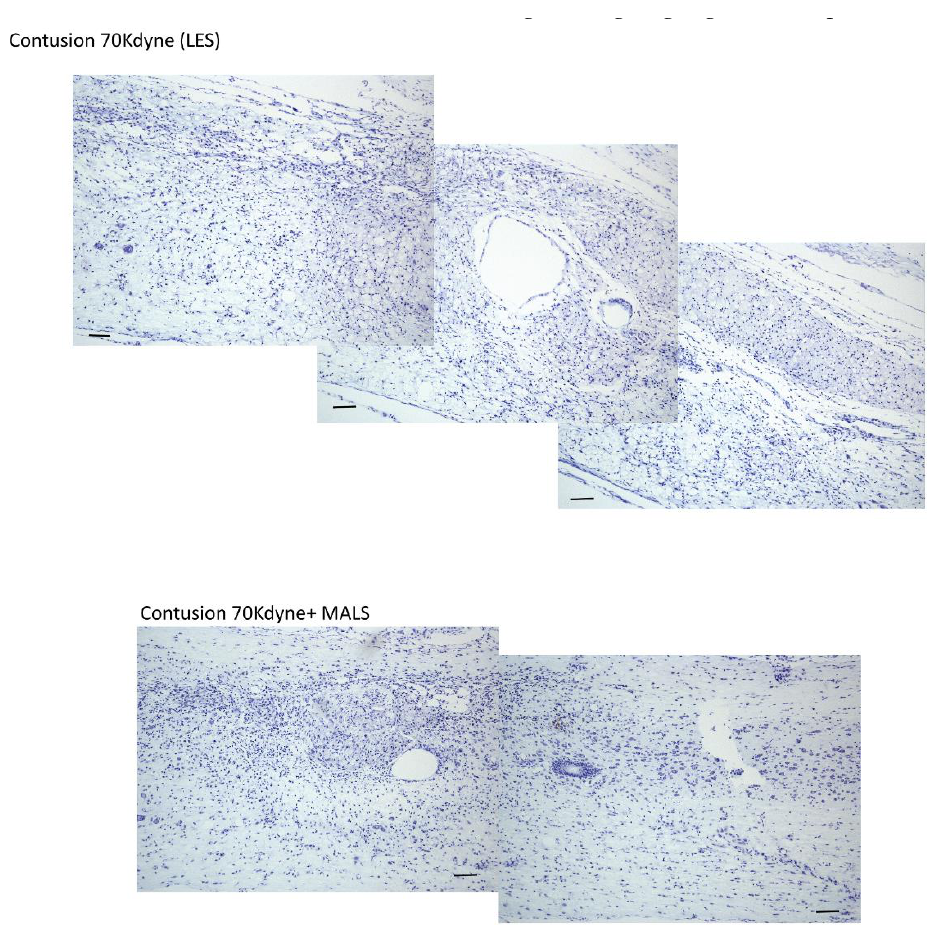
Figure 6. MALS tissue promotes re-growth of neurons. Spinal cord longitudinal sections were examined for DCX (red) expression 35 days after MALS transplant. Scale bar: 100 µm. The graph shows the quantification of positive cells (percentage) in sections taken at the lesion epicenter, 2 mm rostral or caudal to the lesion epicenter (please see schematic representation). Values represent mean ± SD. We determined the statistical differences by means of one-way ANOVA test followed by Bonf erroni’s post -test. ** p < 0.01, *** p < 0.001 vs. LES, # p < 0.05, ## p < 0.01, ### p < 0.001 vs. LS. (n = 4 mice; 2 sections/mouse; 3 fields/section area).